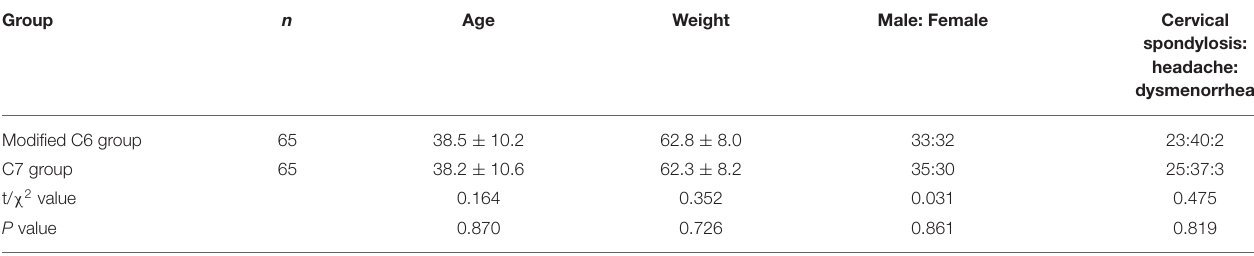
TABLE 1 | Comparison of general conditions between the two groups ( n = 65). Group n Age Weight Male: Female Cervical